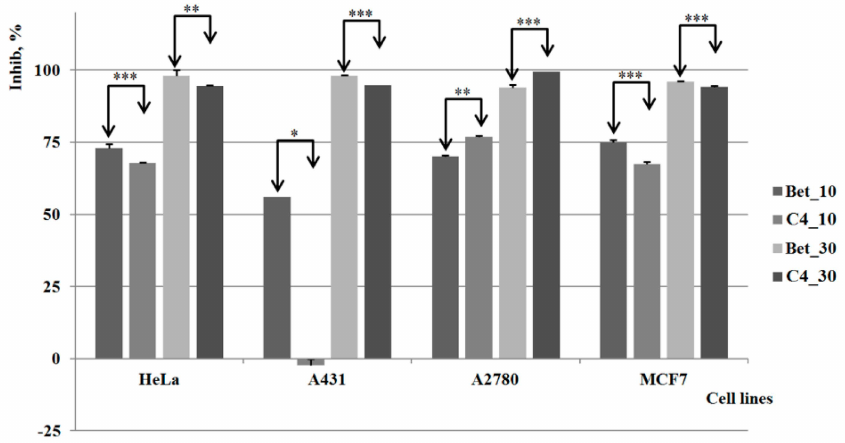
Figure 7. The results of the in vitro tests for C4 vs. control group (Bet) *, **, *** indicate p < 0.05, p < 0.01, and p <